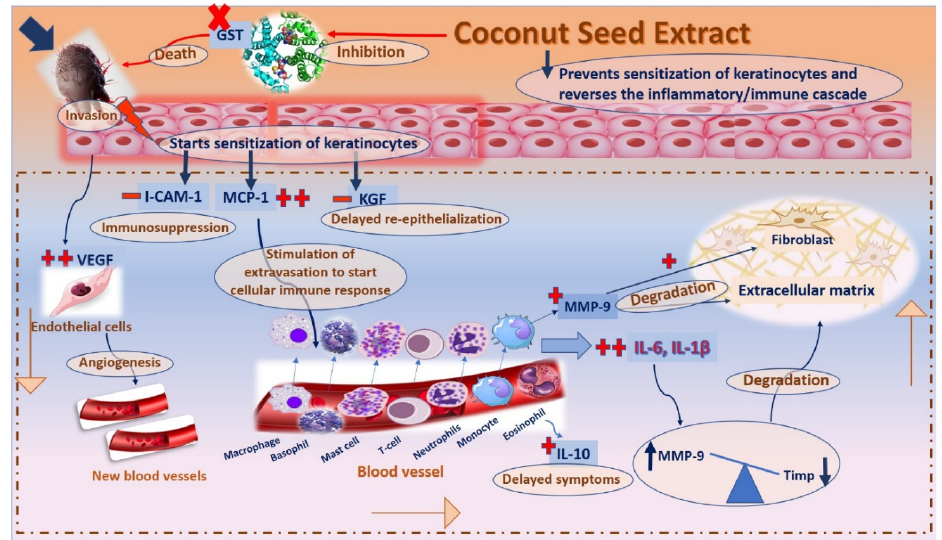
Figure 9. A schematic diagram for the proposed mechanism of action of coconut seed extract on scabies-infected rabbits.